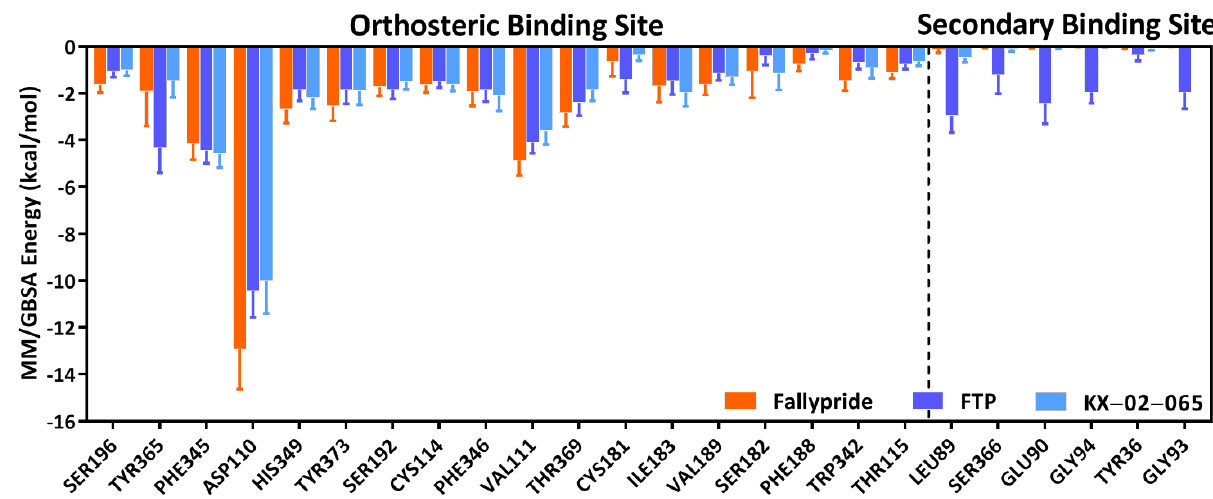
Figure 6. Total MM/GBSA binding free energy (kcal/mol) contribution of ligands to residue pairs.